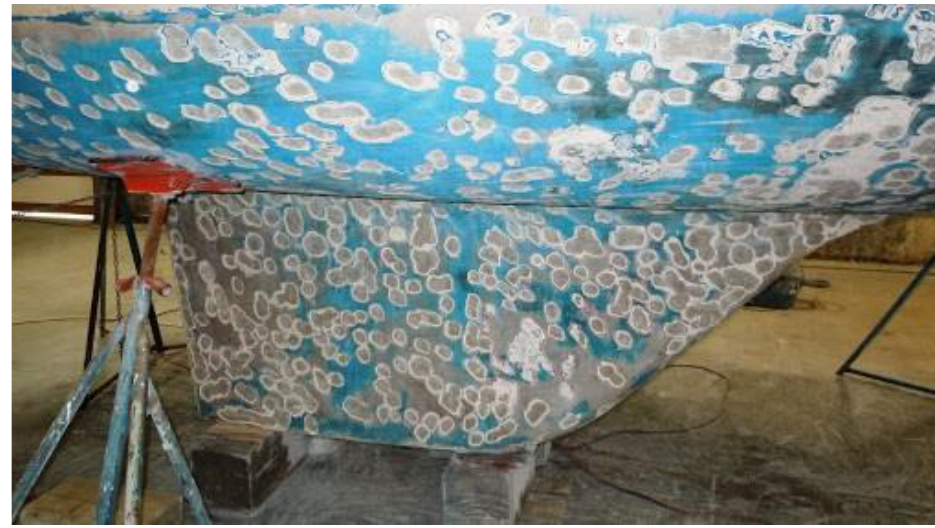
Figure 2. Osmosis foci on the yacht’s hull [5].